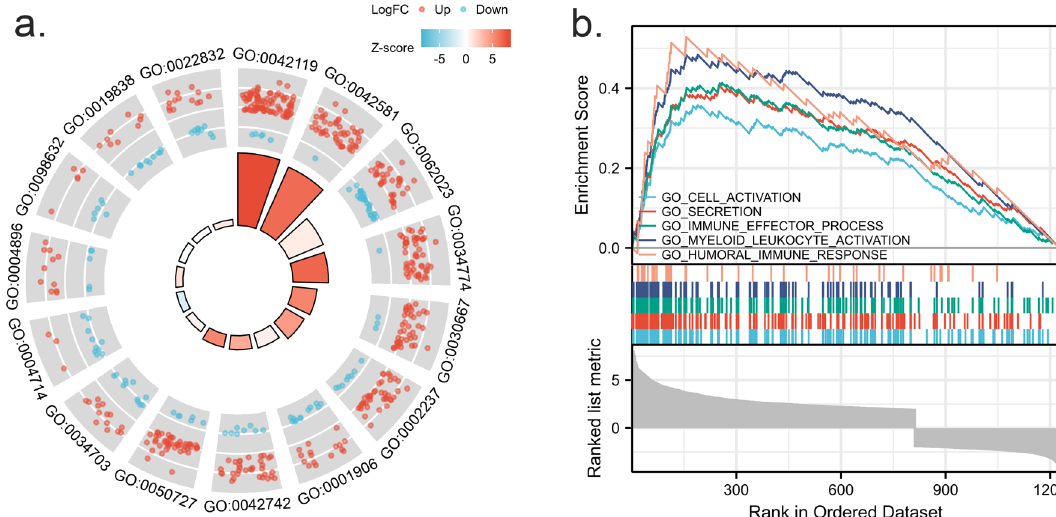
Figure 2. GO enrichment analysis of differentially expressed genes. ( A ): Function enrichment circle plot of top5 enriched GO terms from BP, MF and CC analysis. Red color as upregulated genes; Blue color as downregulated genes, with each dot representing a gene. The height of the column in the middle indicated the number of enriched genes. ( B ): GSEA functional analysis plot of immune-related genes. Genes with functions relating to cell activation, secretion, immune effector process, myeloid leukocyte activation, and humoral immune response are predominantly enriched in the front half section, suggesting an improved function in sepsis.